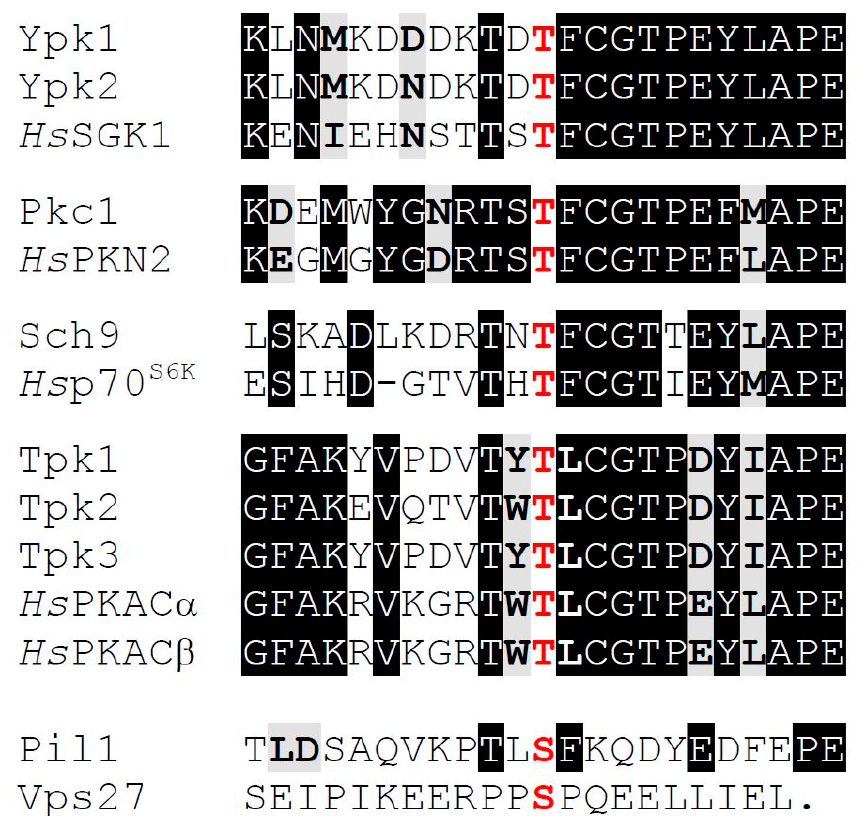
Figure 4. Sites phosphorylated by Pkh1 and Pkh2. The activation loop sequence in the indicated S. cerevisiae protein kinases (phosphorylated by Pkh1 and Pkh2) and their corresponding human counterparts (phosphorylated by PDK1), a putative Pkh1 site in the fungal-specific protein Pil1, and a purported Pkh1 site in the ESCRT-0 subunit Vps27 were aligned by anchoring on the residue phosphorylated (bold red). Identities (white letters on black boxes) and standard conservative substitutions (bold letters on grey boxes), and a one-residue gap (hyphen) to maximize one alignment, are indicated. Period (.) indicates the end of the open-reading-frame. Sequence sources were the Saccharomyces Genome Database (SGD; http://www.yeastgenome.org; Stanford University, CA, USA) and the Proteome™ Database of geneXplain GmbH (https://portal.genexplain.com/cgi-bin/portal/ login.cgi; Wolfenbüttel,